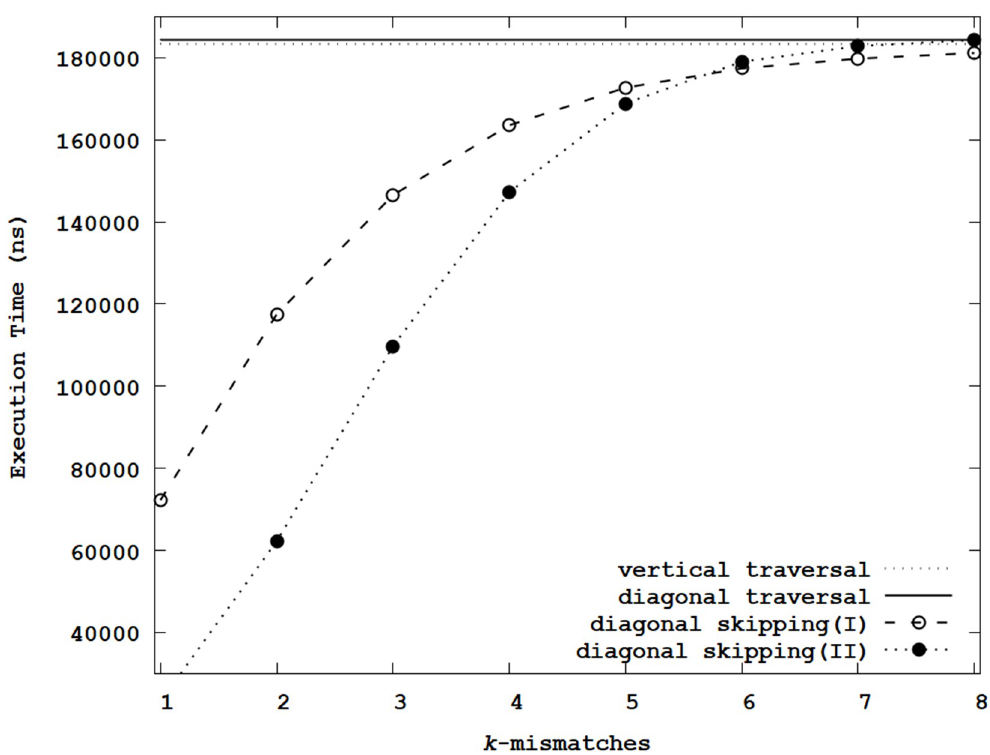
Fig 8. Average execution times for the generalized edit distance metric using keyboard character